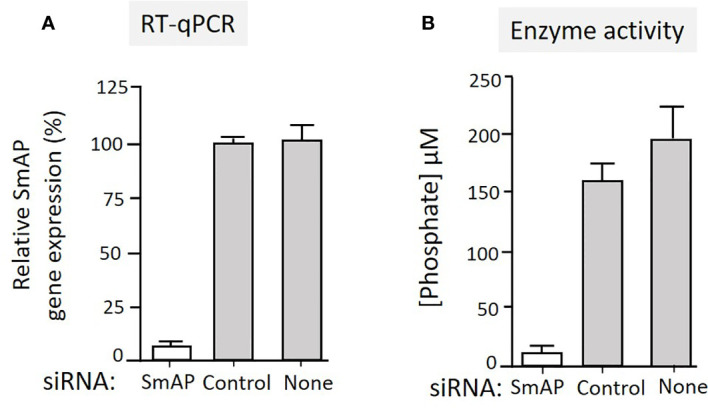

(A) Relative SmAP gene expression determined by RT-qPCR in adult male worms 48 h after treatment with an siRNA targeting the SmAP gene or with an irrelevant siRNA (Control) or with no siRNA (None), as indicated. The expression level displayed by the control worms is set at 100%. (B) Phosphate generation (µM, mean +/-SD, n = 5) by individual live adult male worms seven days after treatment with SmAP siRNA or an irrelevant siRNA (Control) or no siRNA (None) in the presence of PLP. Parasites treated with SmAP siRNA generate significantly less phosphate compared to either control (One-way ANOVA, P < 0.001).